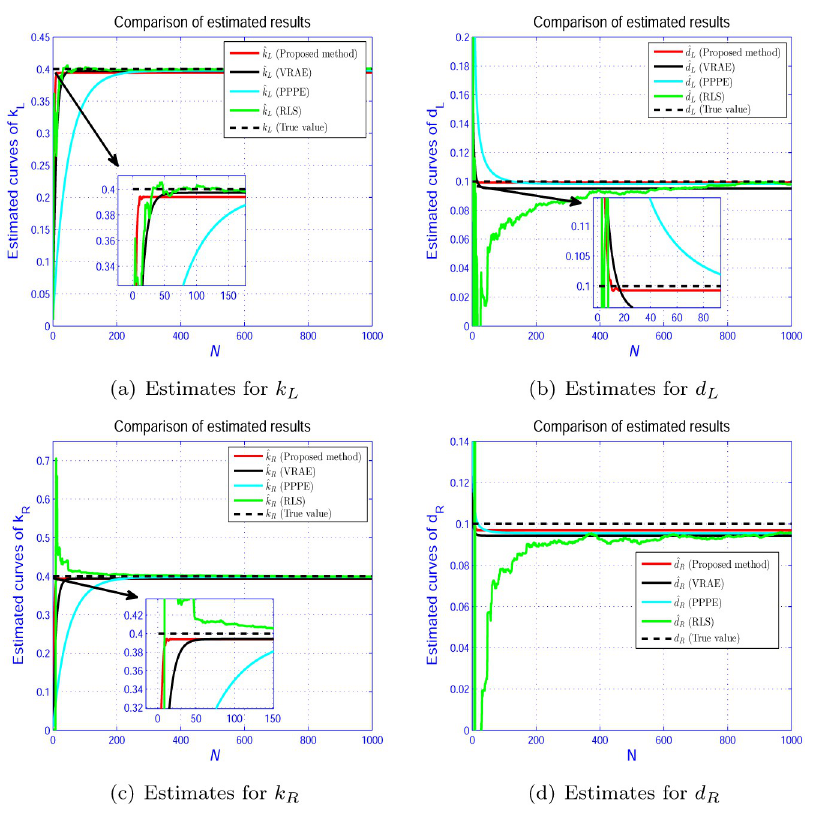
Fig 6. Parameter estimation for deadzone. (a) Estimates for k L . (b) Estimates for d L . (c) Estimates for k R . (d) Estimates for d R